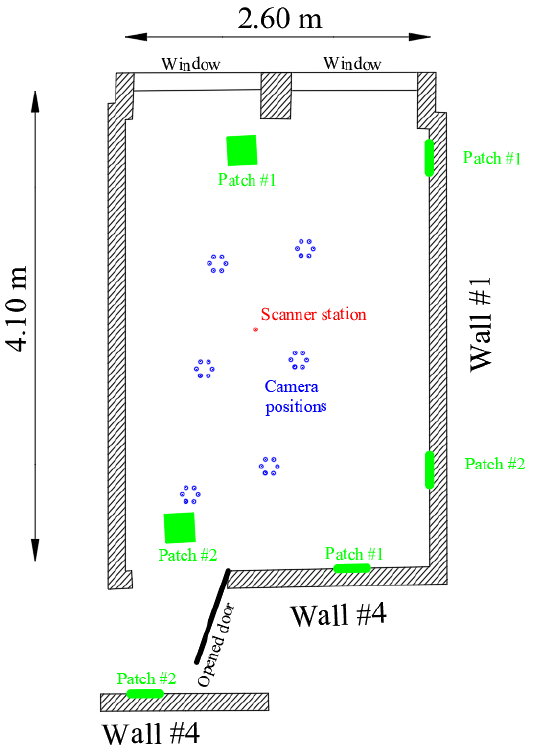
Figure 7. Layout of the surface patches used for evaluation.